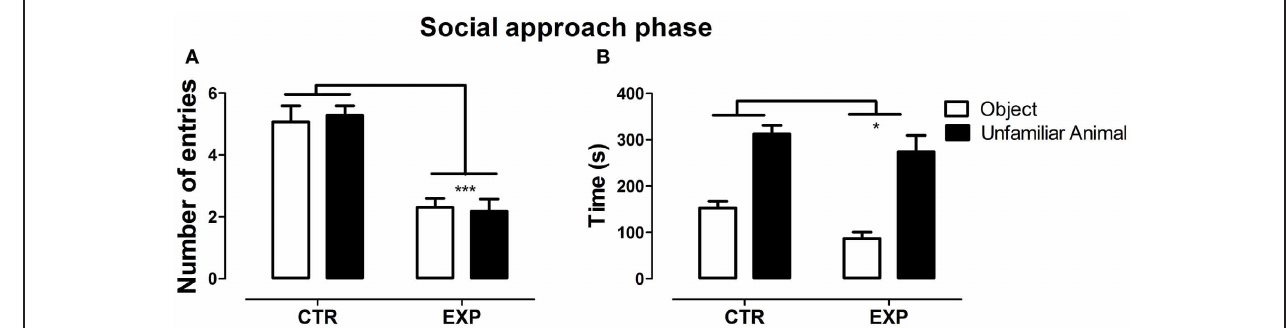
(EXP), n = 16. EXP showed less locomotor activity compared to CTR ( ∗∗∗ p < 0 . 0001), but both groups spent more time on the side with unfamiliar rat.